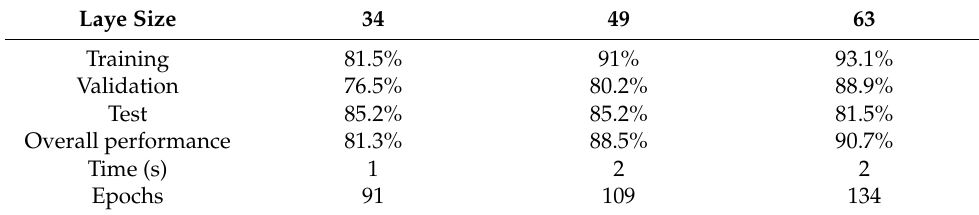
Table 4. Results of the ANNs with the averages of sequences of the FFT. Laye